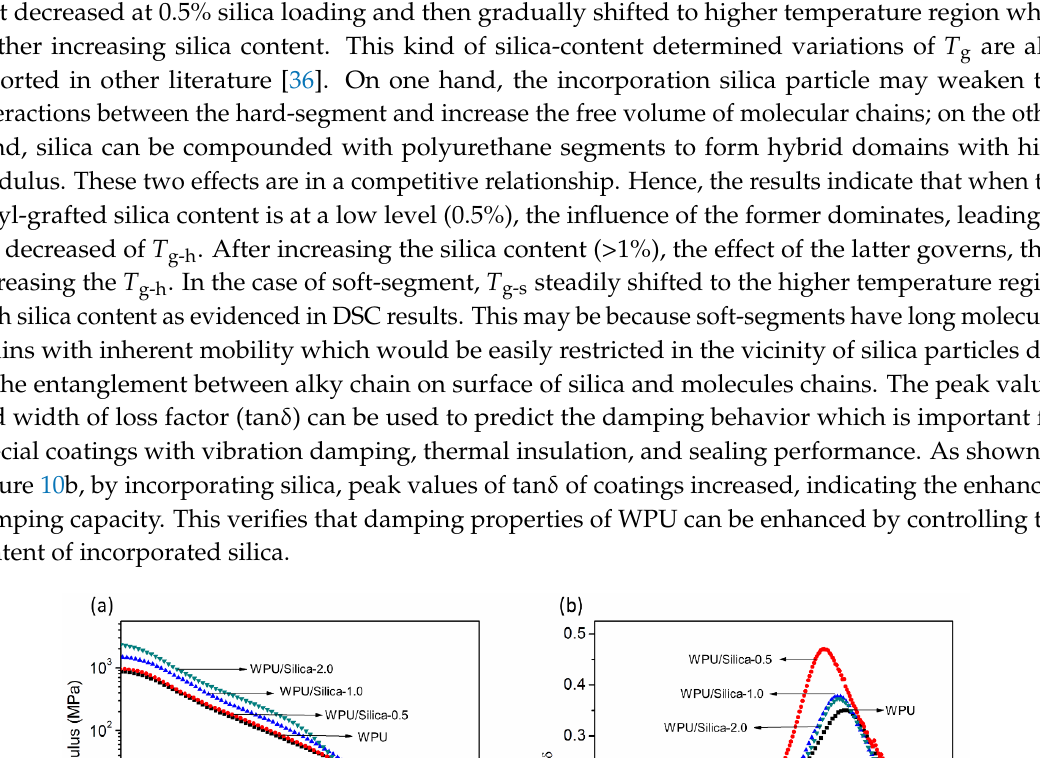
Figure 11. Stress-strain curves of WPU and WPU/Silica coatings.